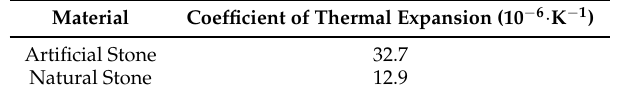
Table 2. Coefficients of thermal expansion of the artificial stone and the natural stone, measured by thermo-mechanical analysis in a DMA.